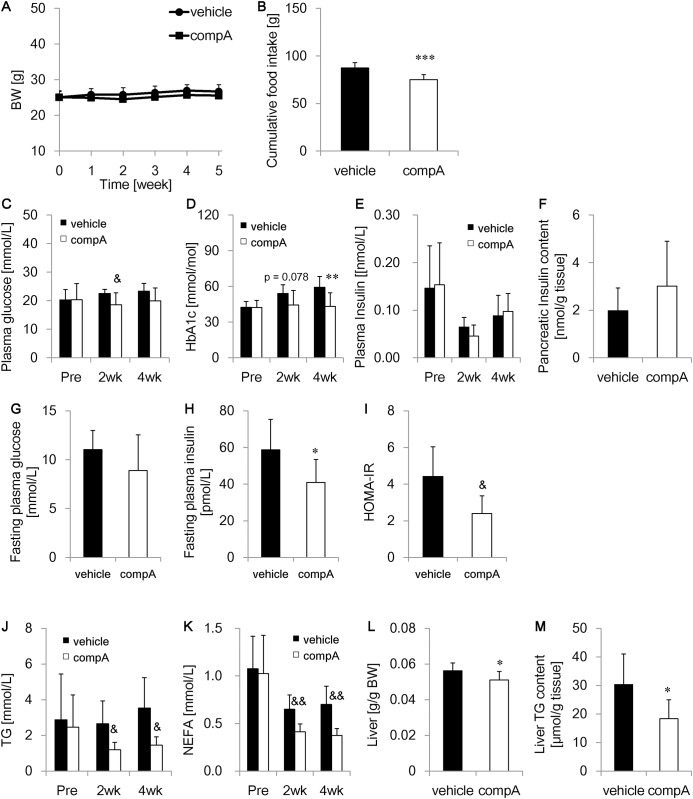
Anti-diabetic effect of compA in high-fat diet-streptozotocin (HFD-STZ) mice.Male HFD-STZ mice were orally administrated vehicle or 30 mg/kg compA for 6 weeks. Postprandial plasma parameters and blood GHb levels were measured every 2 weeks. Overnight fasting glucose and insulin levels were monitored after 5-week dosing. The liver, pancreas and small intestine were collected after 6-week dosing. (A) Time course of changes in body weight (BW). (B) Mean daily food intake. Mean (C) plasma glucose levels, (D) blood glycated hemoglobin (GHb) levels, and (E) plasma insulin levels before and 2 or 4 week after compA treatment. Mean (F) pancreatic insulin levels, (G) fasting plasma glucose levels, (H) plasma insulin levels, (I) HOMA-IR levels, (J) plasma triglyceride (TG) levels, (K) plasma non-esterified fatty acid (NEFA) levels, (L) liver weight, and (M) hepatic TG levels. n = 8. *: P < 0.05, **: P < 0.01, ***: P < 0.001 vs. the vehicle-treated group by Student’s t-test. &: P < 0.05, &&: P < 0.01 vs. the vehicle-treated group by Aspin–Welch test.